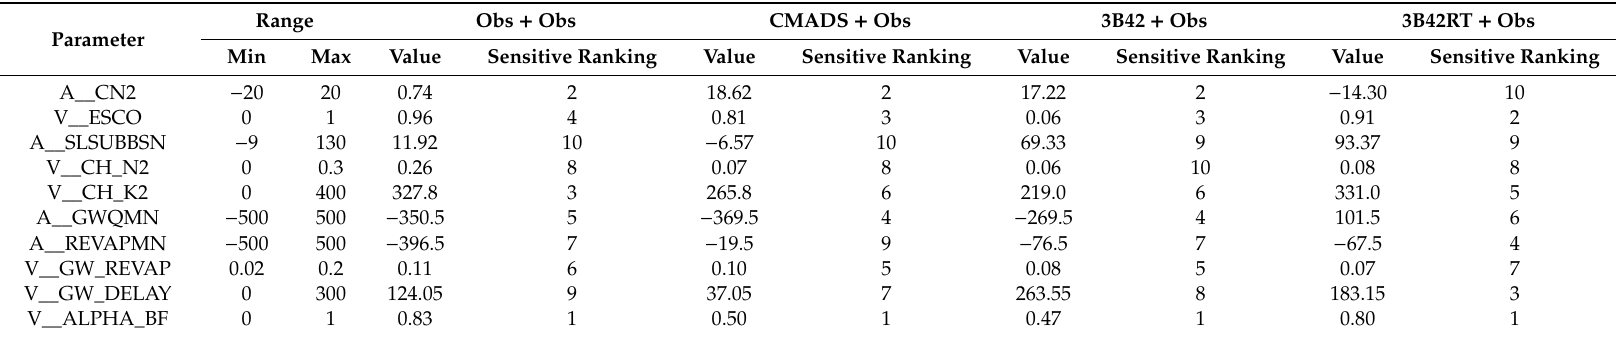
Note: A means a given value is added to the existing parameter value, and V indicates the existing parameters value is to be replaced by a given value. CN2 = initial SCS runo ff curve number for moisture condition II; ESCO = soil evaporation compensation factor); SLSUBBSN = average slope length; CH_N2 = Manning’s n value for the main channel; CH_K2 = e ff